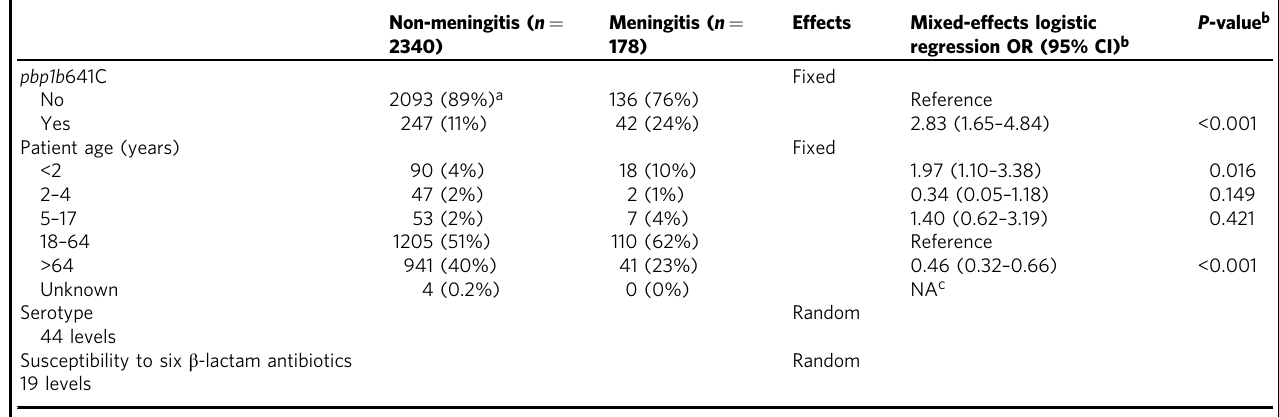
Table 2 Analysis of invasive pneumococcal isolates in the con fi rmatory cohort